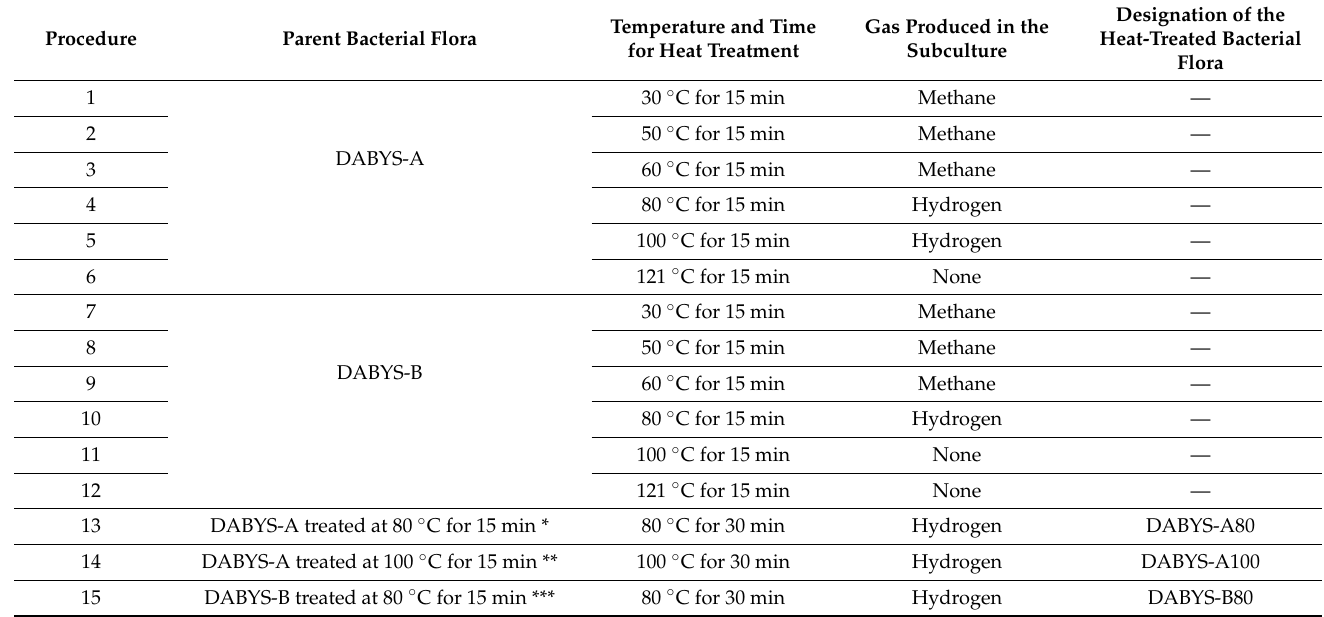
Figure 1. Biogas yields of the heat-treated DABYS microflorae. Data are means for two-time gas chromatography analysis.